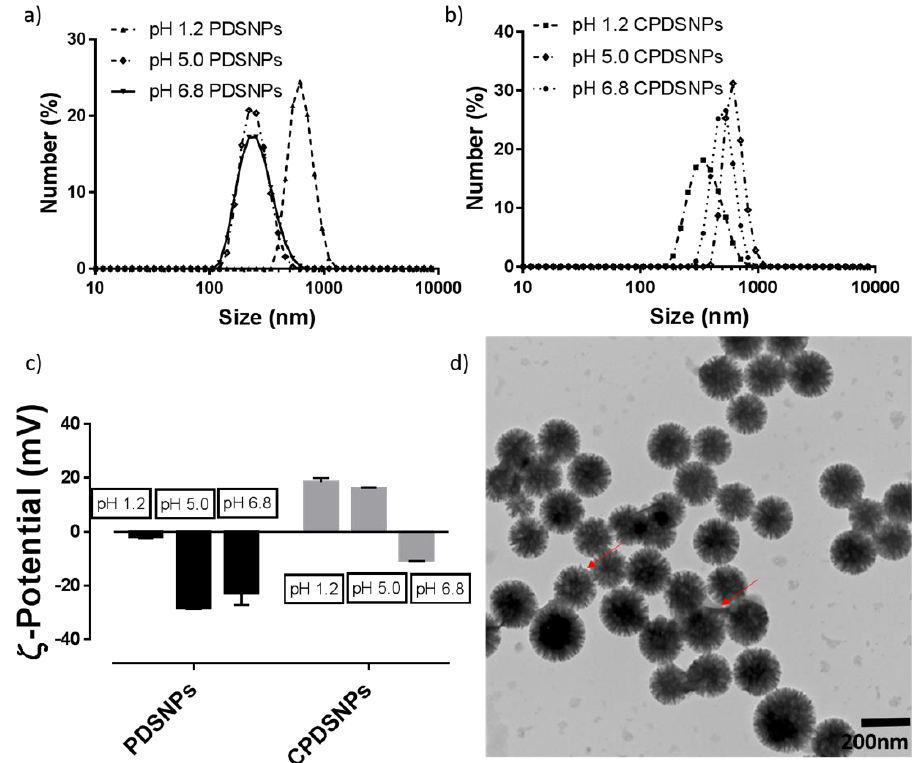
Figure 3. ( a , b ) The hydrodynamic sizes of uncoated and chitosan-coated PDSNPs behaved oppositely, indicating different assembly of CDSNPs, as the latter tended to aggregate as pH increased. ( c ) ζ -potential profile of the particles. (All data are n = 3, mean ± SD). ( d ) TEM image of CPDSNPs; radial pore network was clearly masked upon coating with chitosan.